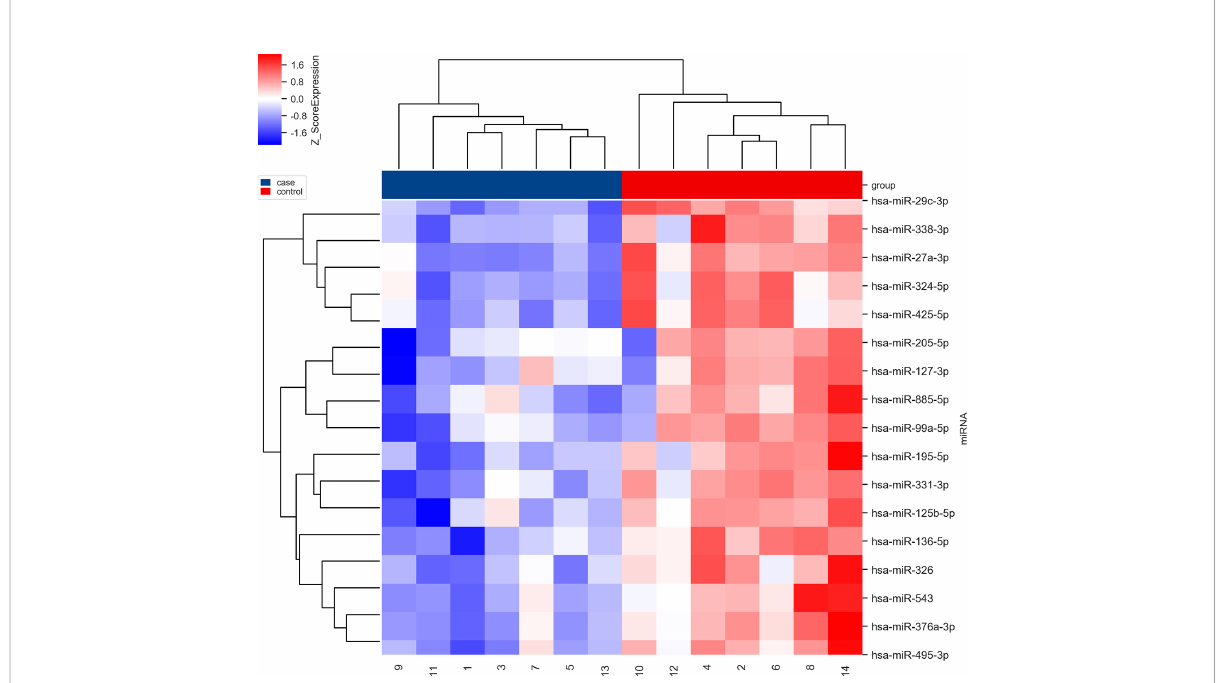
FIGURE 2 The clustering map of dysregulated microRNAs before (in blue) and after (in red) NACT in the fi rst seven SCC patients. The blue ones mean downregulated and the red ones mean